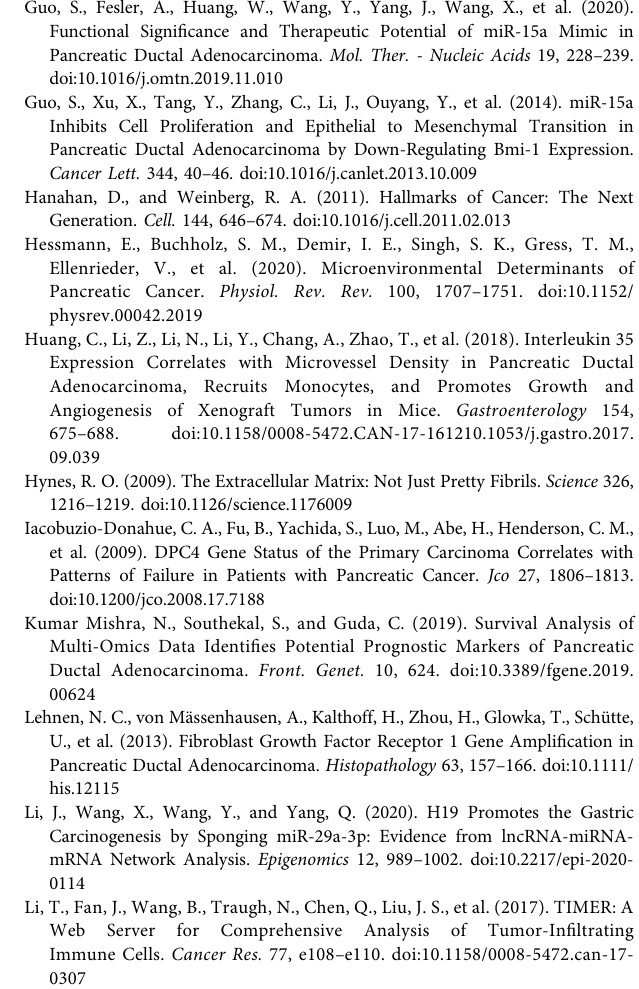
Supplementary Figure S1 | Fraction of M1 macrophage cells was positively associated with COL1A2 expression (A) and LAMA3 expression (B) . Monocyte cells were positively associated with LAMA3 (C) and ITGA2 (D)